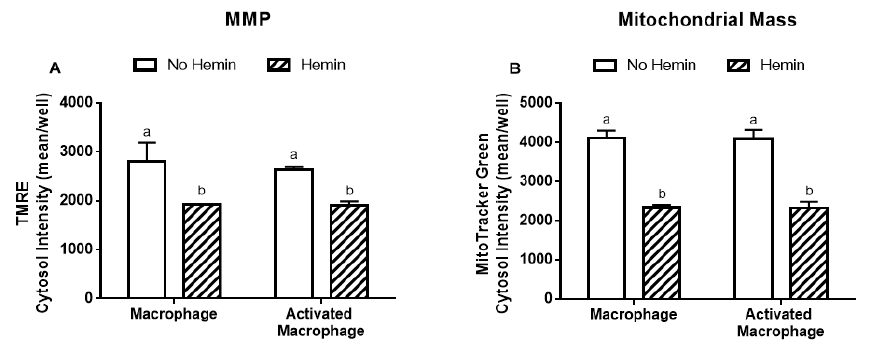
Figure 5. MMP and mitochondrial mass in macrophages are reduced by hemin. ( A ) MMP and ( B ) mitochondrial mass in macrophages and activated macrophages, in the absence or presence of 10 μ M hemin for 72 h. MMP and mitochondrial mass were detected by immunofluorescence using a confocal imaging system. Values with different superscript letters (a and b) indicate significant differences ( p < 0.05) between groups. For all bars with the same letter, the difference between the means is not statistically significant. MMP, mitochondrial membrane potential; TMRE, tetramethylrhodamine.